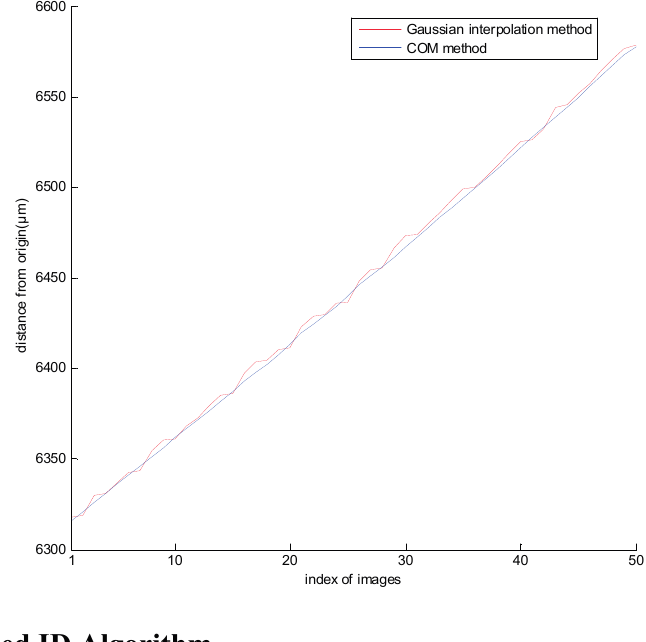
Figure 1. COM vs. Gaussian interpolation